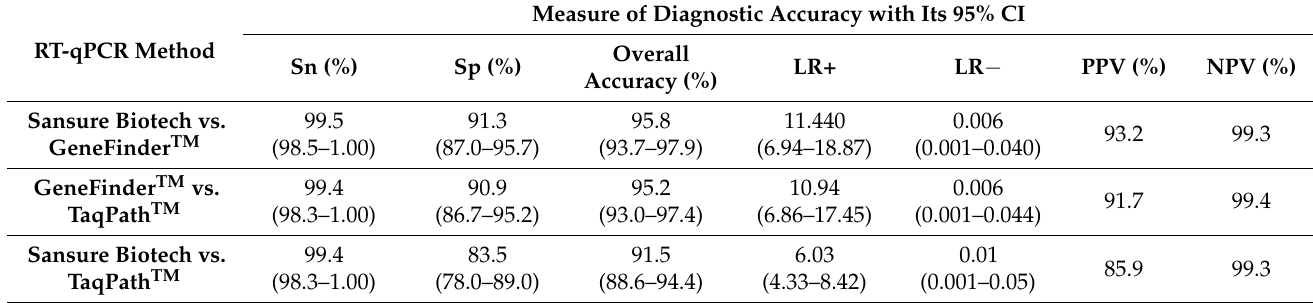
Table 5. Diagnostic accuracy of three RT-qPCR methods.